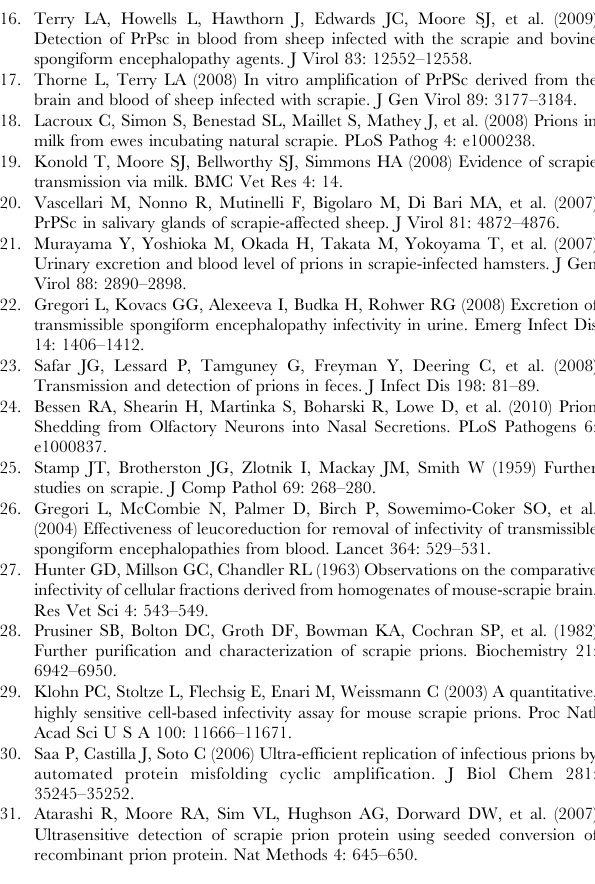
Figure S1 Guanidine HCl effects in RT-QuIC reactions seeded with sheep scrapie and deer CWD. Dilutions of sheep scrapie (10 -3.9 ; , 100 fg PrP Sc ) (A) and deer CWD (10 -5.3 ; , 40 fg PrP CWD ) (B) BH’s and corresponding dilutions of NBH from the same species were used to seed RT-QuIC reactions. The guanidine-HCl concentration in the reactions was varied as designated. All reactions utilized the homologous full length rPrP C substrates. The